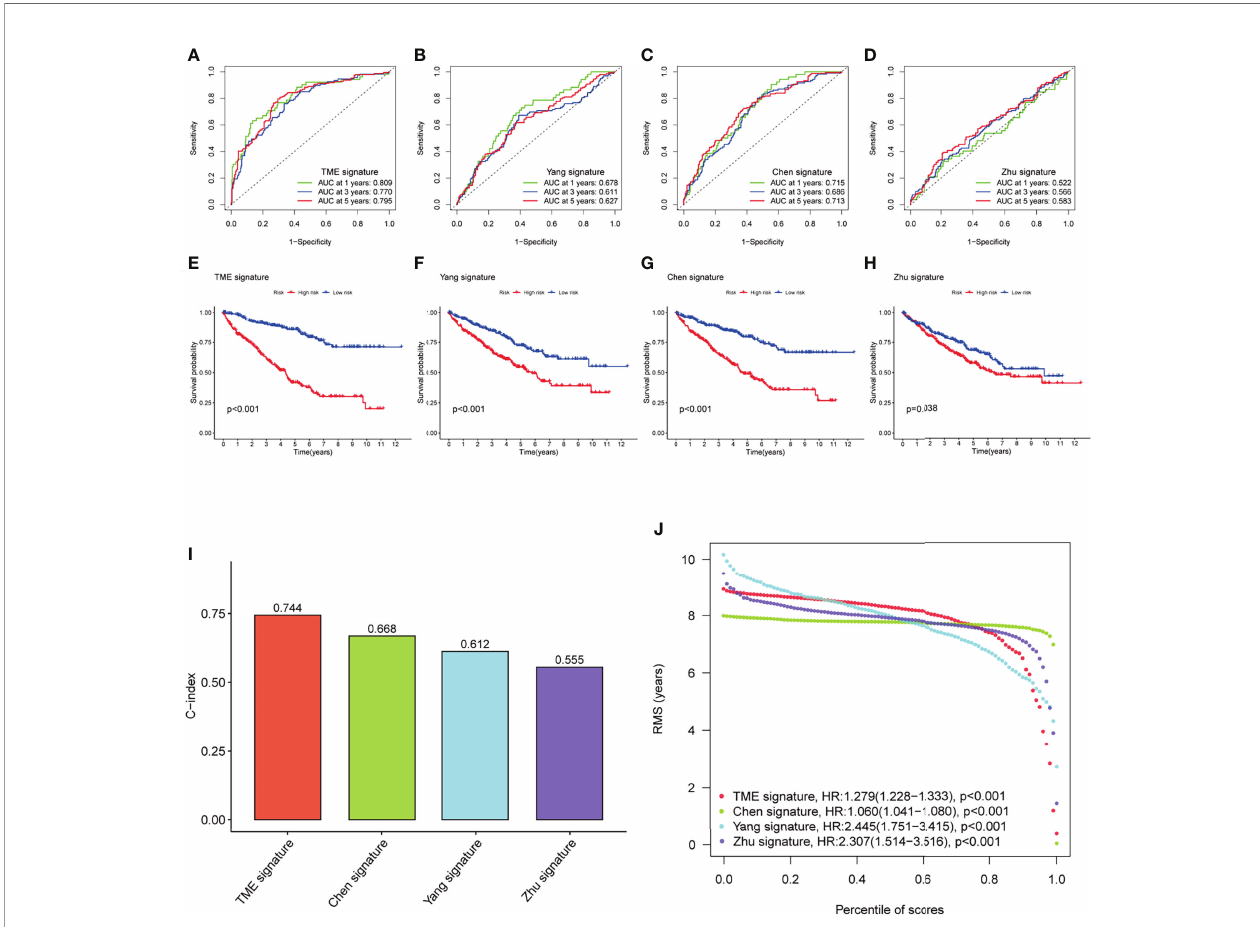
FIGURE 7 | Performance of the TME-related signature compared with other prognostic signatures in predicting OS in KIRC patients. (A – D) ROC curves were used to predict 1-, 3-, and 5-year OS in KIRC patients with our signature and three other published gene signatures. (E – H) Kaplan-Meier survival curves of KIRC patients with our signature and three other published gene signatures. (I) The C-index of the four prognostic signatures including our signature, has the highest C-index. (J) The RMS time curves for our prognostic signature and the Chen/Zhu prognostic signatures showed an overlap of 8 years. TME, tumor microenvironment; OS, overall survival; KIRC, kidney renal clear cell carcinoma; C-index, concordance index; RMS, restricted mean